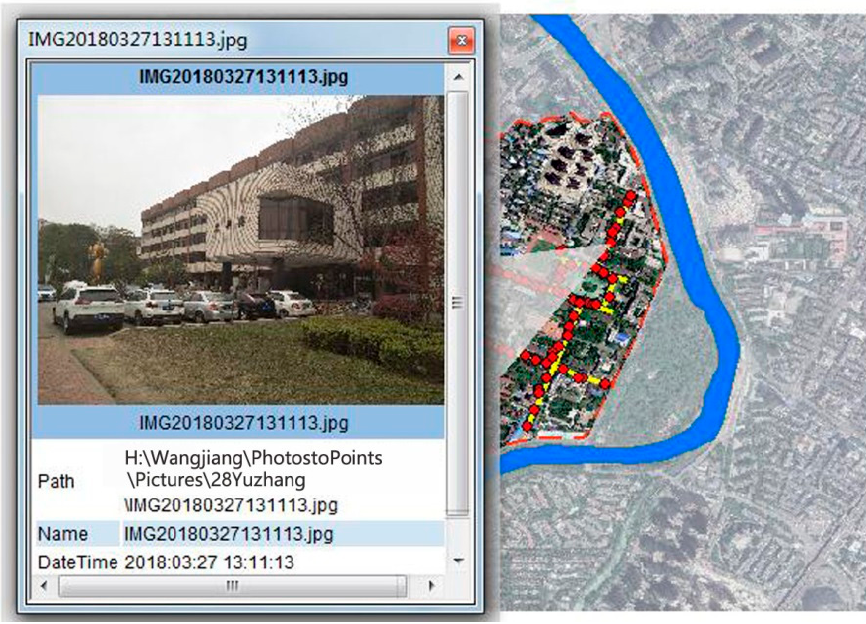
Figure 4. Some investigating photographs of Yuzhang Road